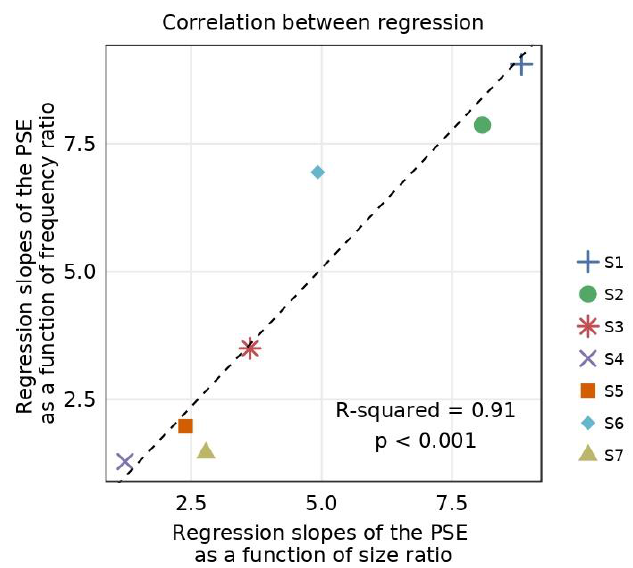
Figure 7. Correlation between the amplitude coefficients of the inverted absolute fit for differing size and frequency ratios. Regression slopes of the PSE for differing frequencies ( y -axis) as a function of the regression slopes of the PSE for differing sizes ( x -axis). The slopes were obtained from linear regression between PSEs and the ratio of size or spatial frequency in Figure 6A and 6B. The dotted line represents correlation between the two linear regressions.